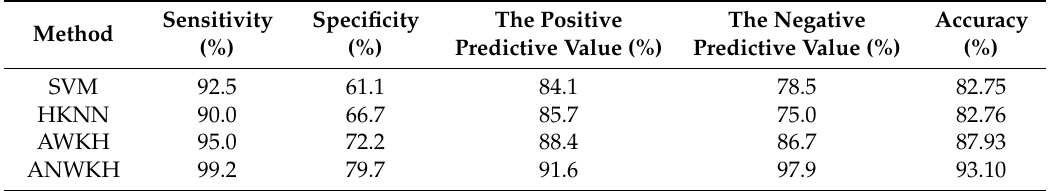
Table 2. The daily classification results of the test set for ANWKH, AWKH, HKNN, and SVM.